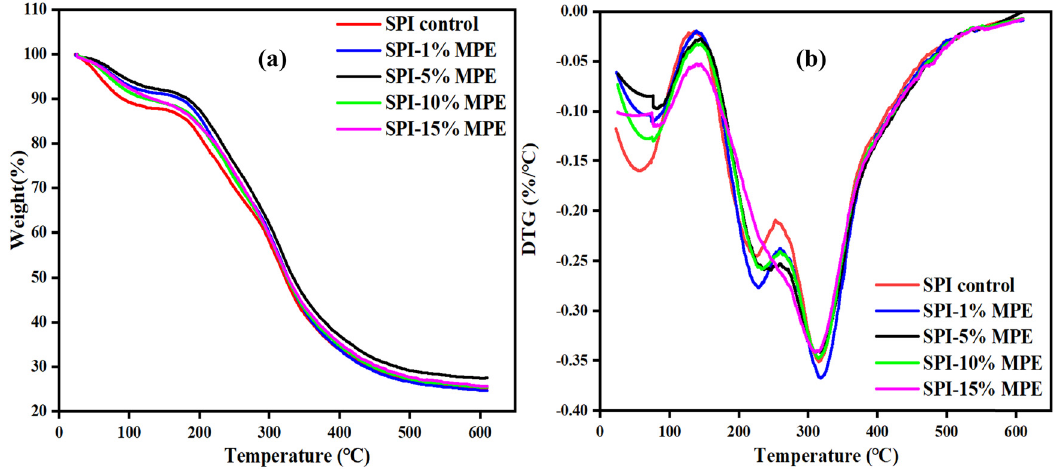
Figure 6: TGA ( a ) and DTG ( b ) patterns of SPI fi lms with and without MPE.